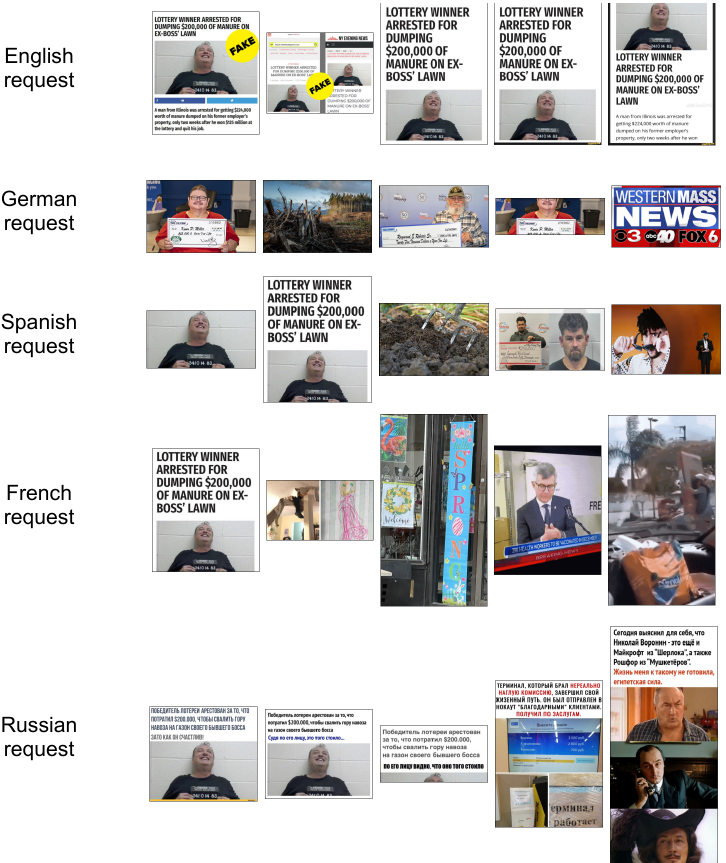
Figure A3. Top 5 images for fake news, “Lottery winner arrested for dumping $200,000 of manure on ex-boss’ lawn”.